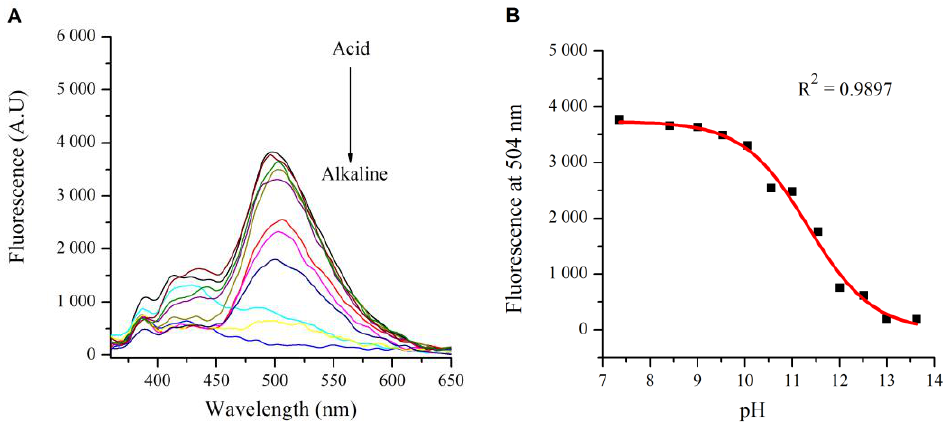
Figure 4. ( A ) Fluorescence of sensor 5 at different pH ( λ EX = 340 nm) and ( B ) titration plot of 5 at λ F = 504 nm in a pH range of 7–14 ( λ EX = 340 nm).